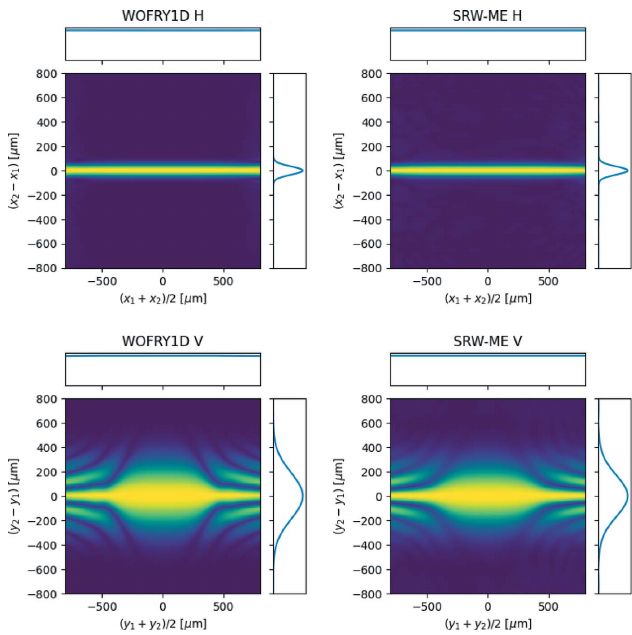
Figure 5 Modulus of the spectral degree of coherence at the slit plane ( z = 36 m) calculated by WOFRY1D and SRW-ME for the horizontal (top row) and vertical (bottom row) directions. The profiles correspond to the lines passing through (0,